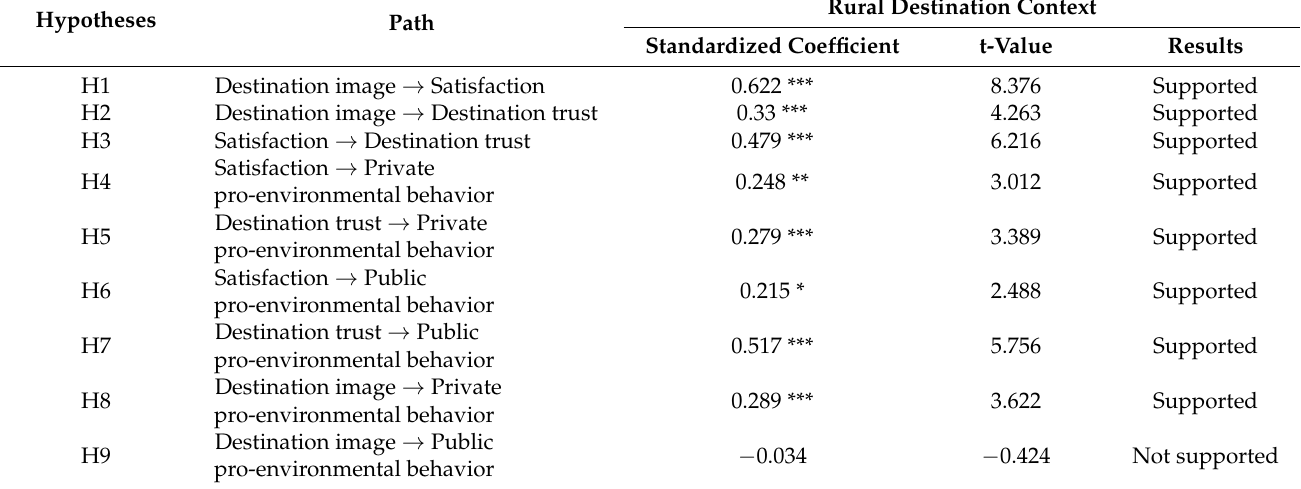
Table 4. Results of structural